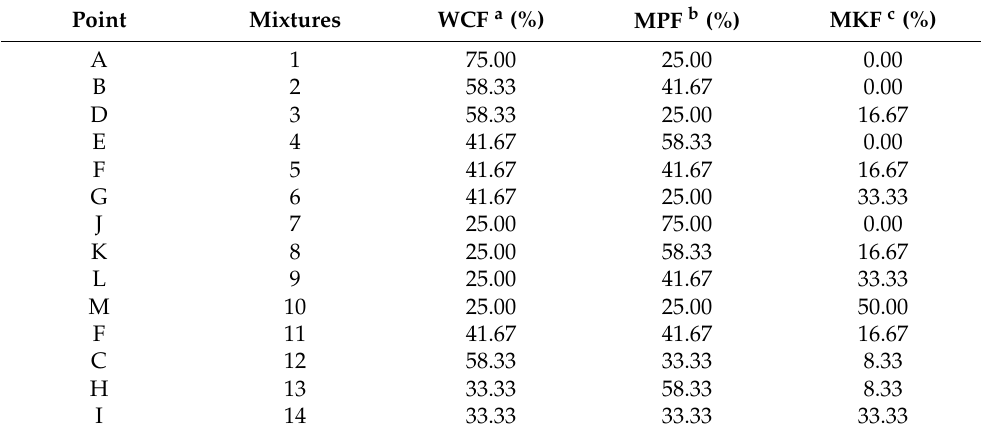
Table 1. Composition of extrudate food with mango by-products in a simplex lattice mixture design.